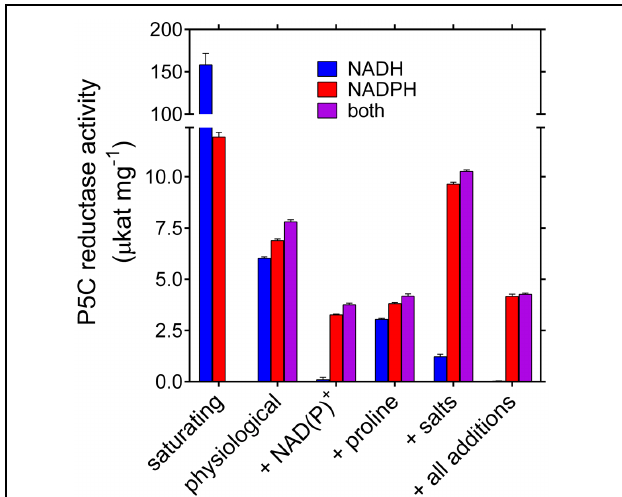
FIGURE 4 | Activity of rice P5C reductase in the presence of physiological concentrations of substrates, products, and ions. Specific activity levels of the purified enzyme were measured under conditions simulating substrate and effector levels inside the plant cell. Available literature data in nmol (g fresh weight) − 1 were converted into molar concentrations by assuming that in cultured plant cells the cytosol may account for about 10% of fresh weight. Activity assays were therefore carried out in the presence of the following concentrations: NADPH 50 μ M, NADH 30 μ M, NADP + 250 μ M, NAD + 160 μ M (Hayashi et al., 2005); L -P5C 100 μ M (Forlani et al., 2013); Pro 15 mM (Forlani et al., 2015a); 5 mM NaCl, 20 mM KH 2 PO 4 /K 2 HPO 4 , 20 mM K 2 SO 4 , 5 mM NH 4 NO 3 , and 5 mM MgSO 4 , resulting in 76 mM K + , 25 mM SO 42 − , 20 mM H 2 PO 4 − /HPO 42 − , 5 mM Na + , 5 mM Mg 2 + , 5 mM NH 4 + , 5 mM NO 3 − , and 5 mM Cl − (Lutts et al., 1996; Taiz and Zeiger, 2010). Presented values are means ± SE over eight replicates; activities under saturating substrate conditions are quoted from Table 2 .